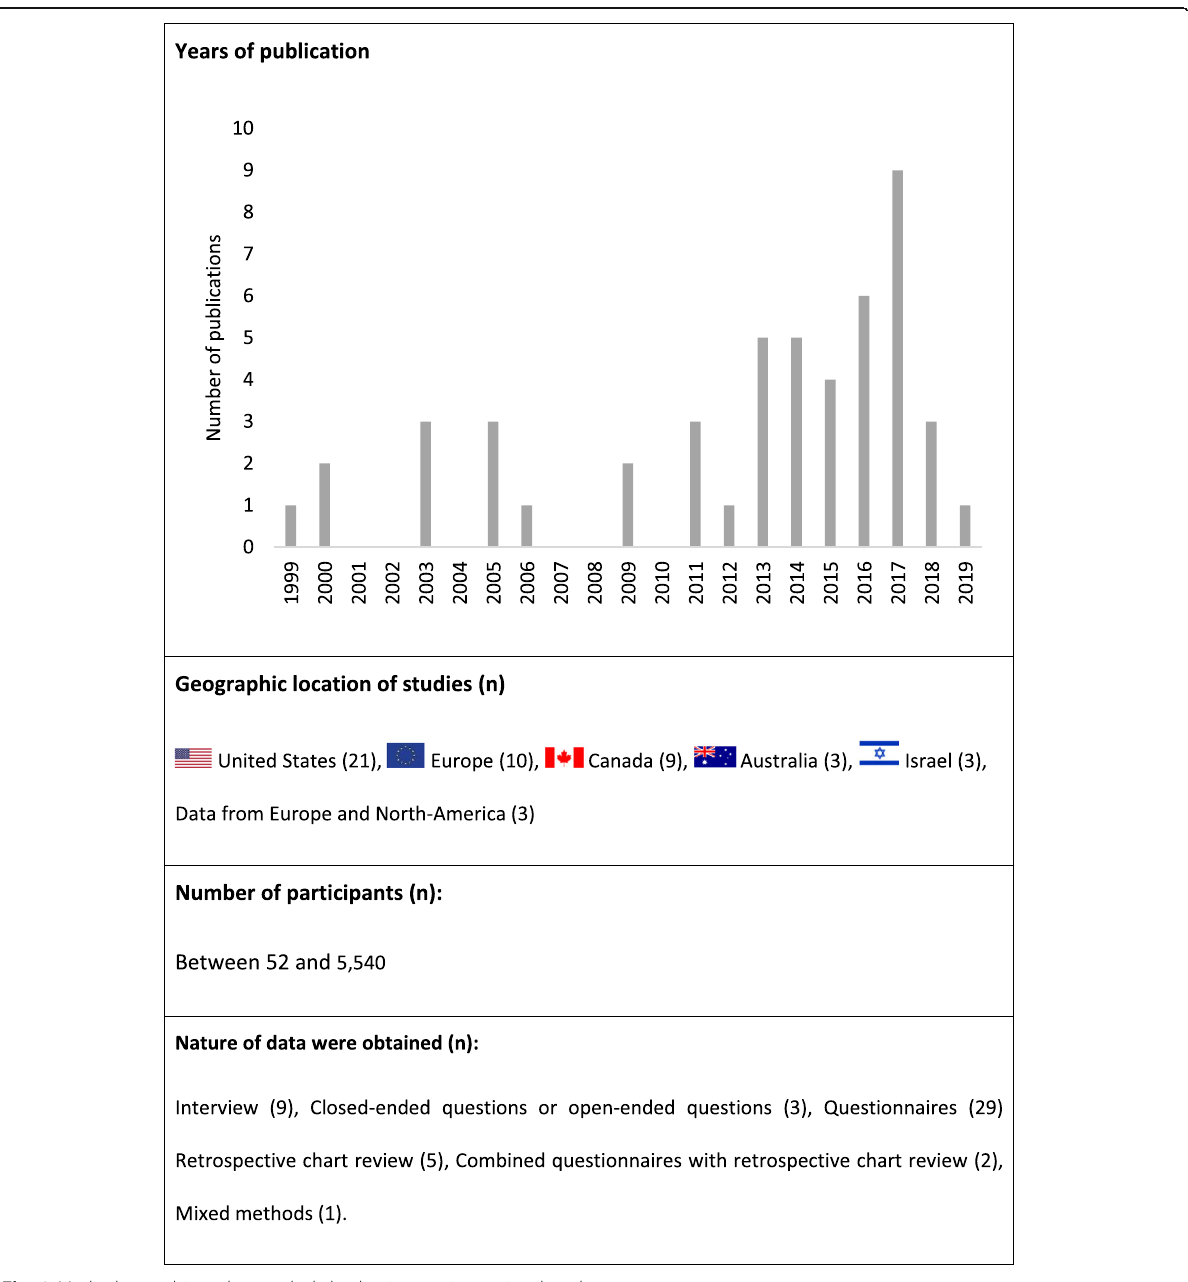
Fig. 2 Medical cannabis and musculoskeletal pain: scoping review key